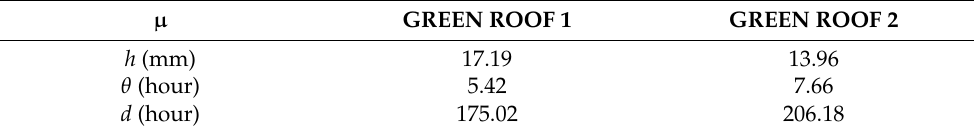
Table 6. Average values of rainfall variables in summer.